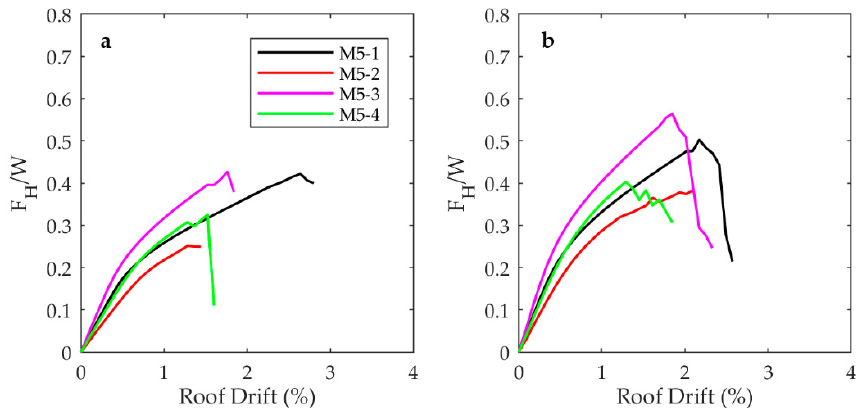
Figure 9. Pushover analysis results for the M5 model: capacity curves for the longitudinal ( a ) and transverse ( b ) directions.